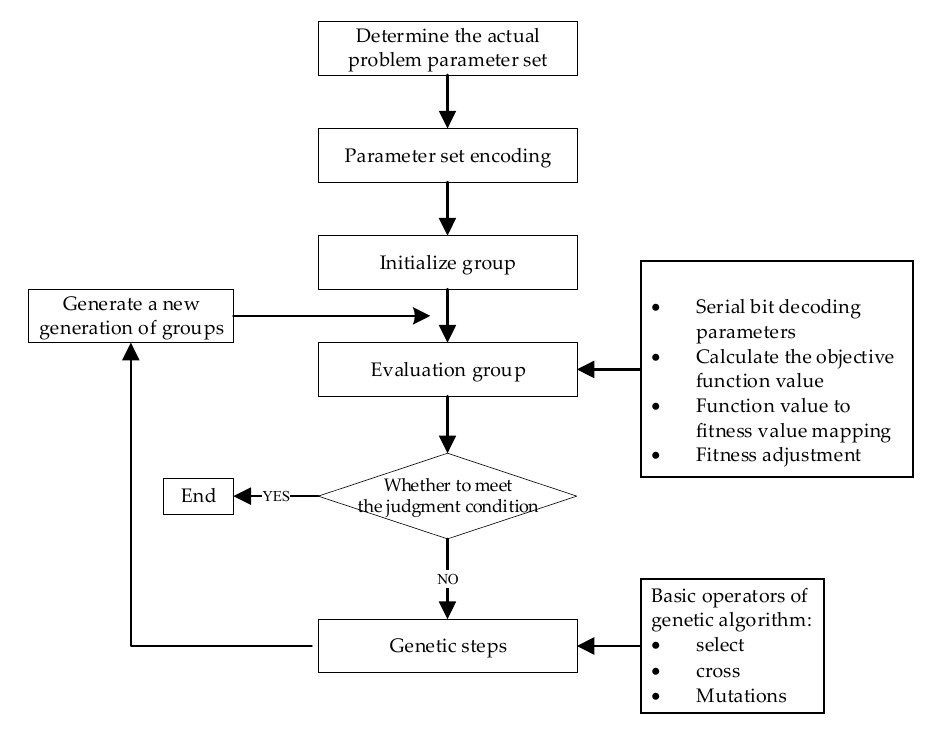
Figure 4. Flow chart of genetic algorithm.